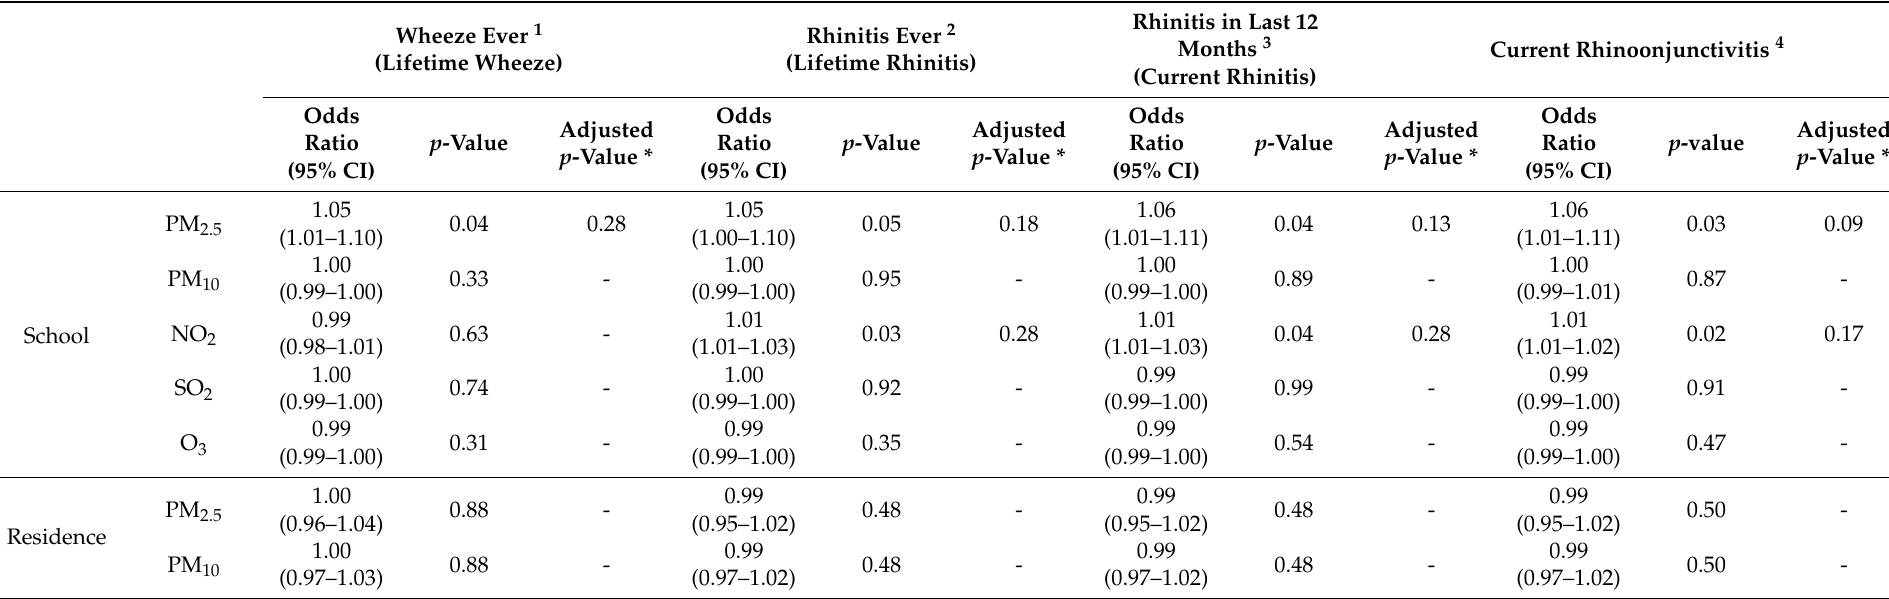
Table 5. Results of GLIMMIX multi-regression model for the associations between air pollutants and health